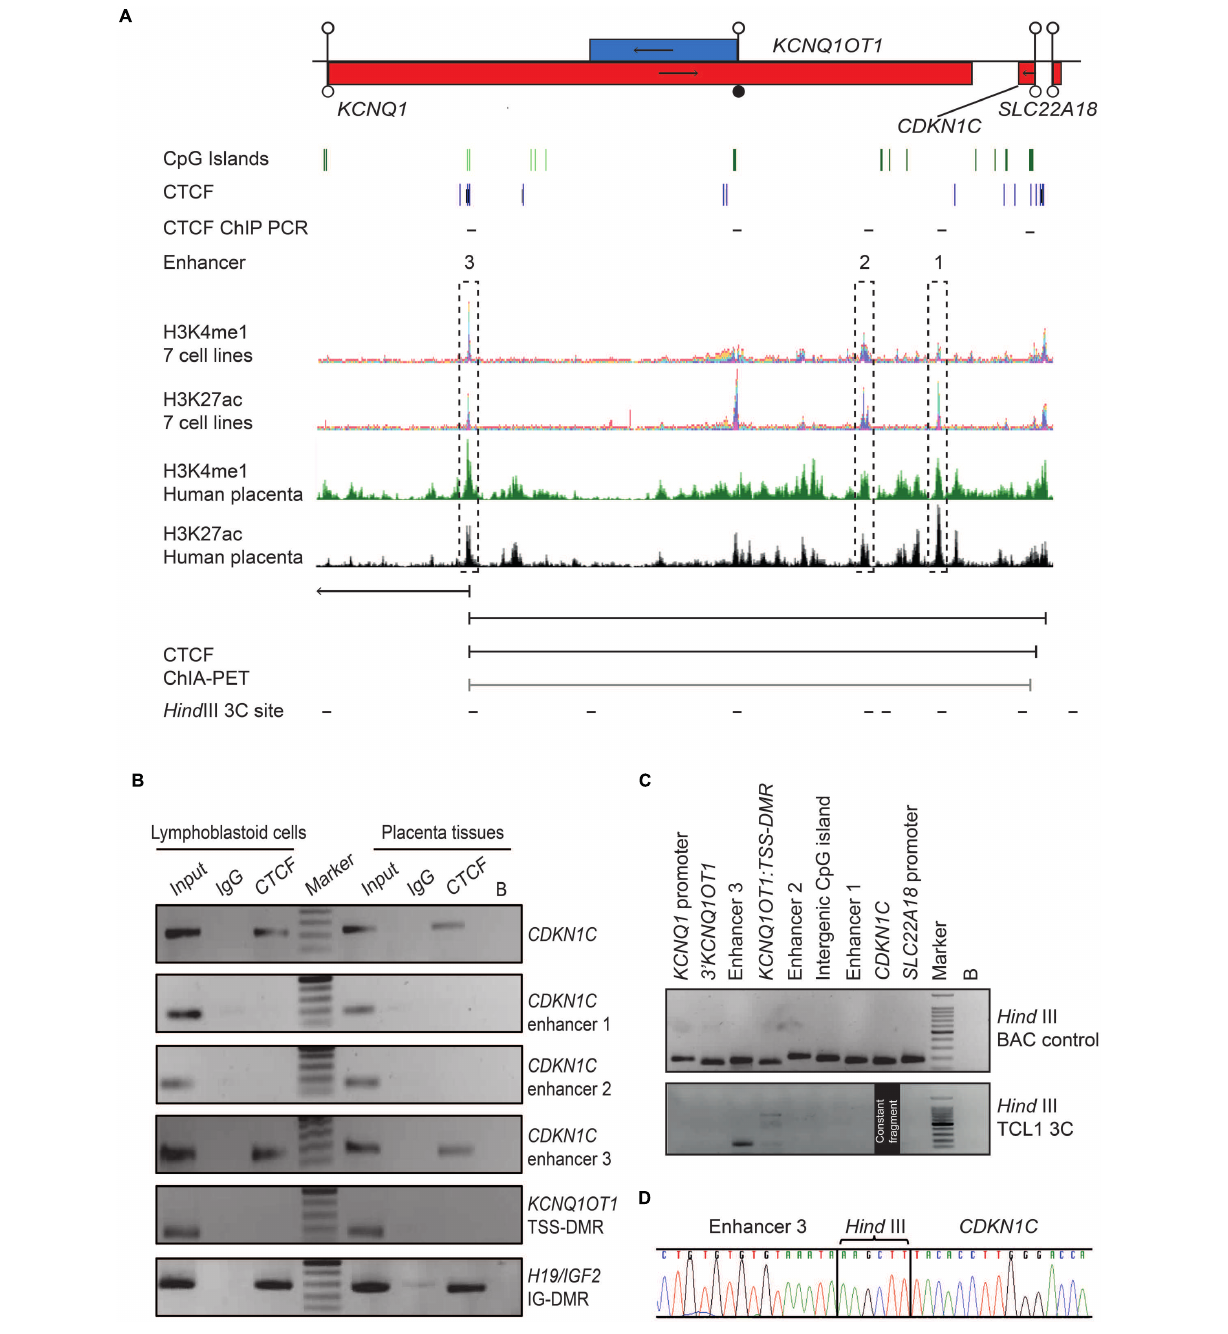
Frontiers in Genetics |